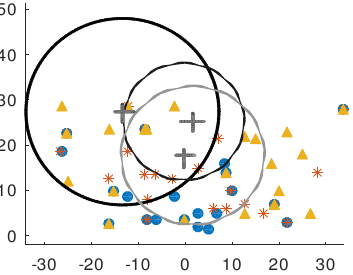
Figure 6. The constrained optimization model (the specific time t ) of finding a circle in 2D that is closest to all cell phone 20 position points, which depend on the time t . Earlier time: solid dots; the minimax black circle. Middle time: asterisk; the minimax wavy black circle. Later time: upper-oriented triangle; the minimax wavy gray circle.